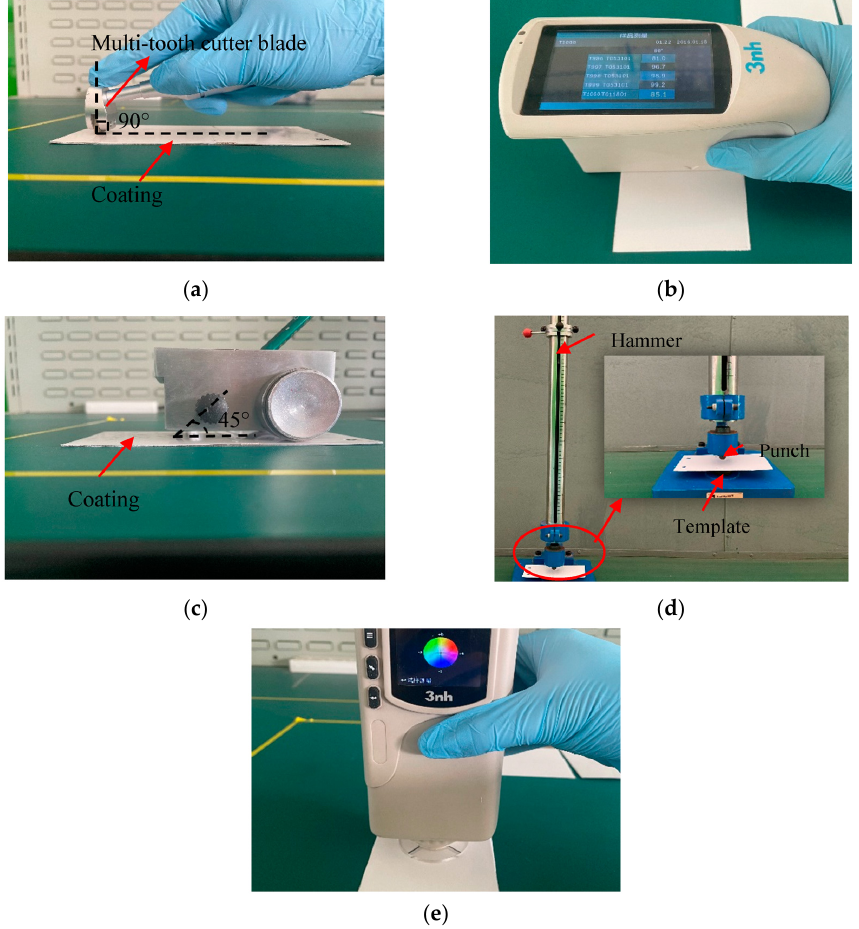
Figure 5. Test equipment and processes: ( a ) adhesion test, ( b ) gloss test, ( c ) hardness test, ( d ) film impact resistance test, and ( e ) color test.